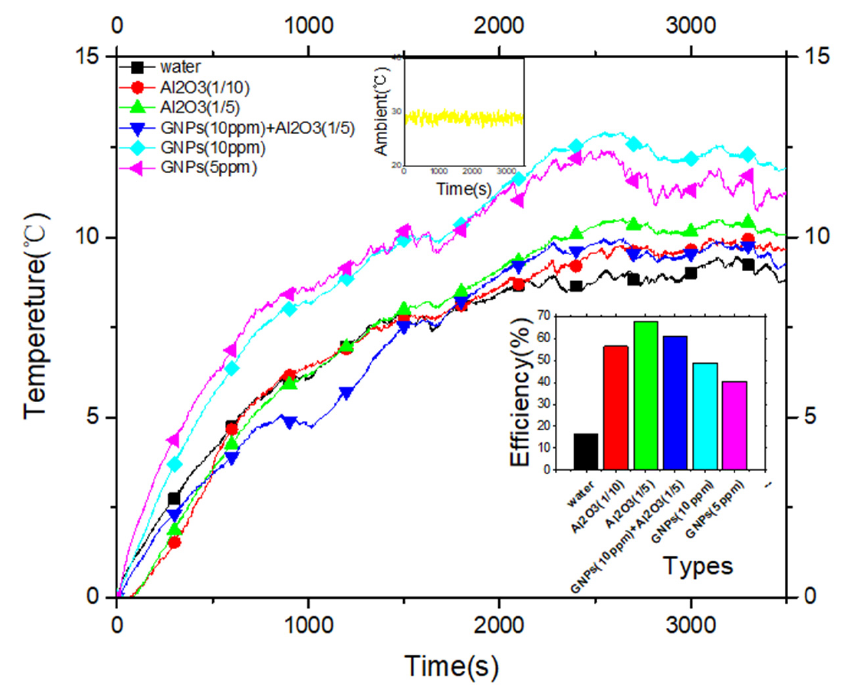
Figure 15. Predicted solar energy absorption efficiency and experimental results of Au − Cu hybrid nanofluid.